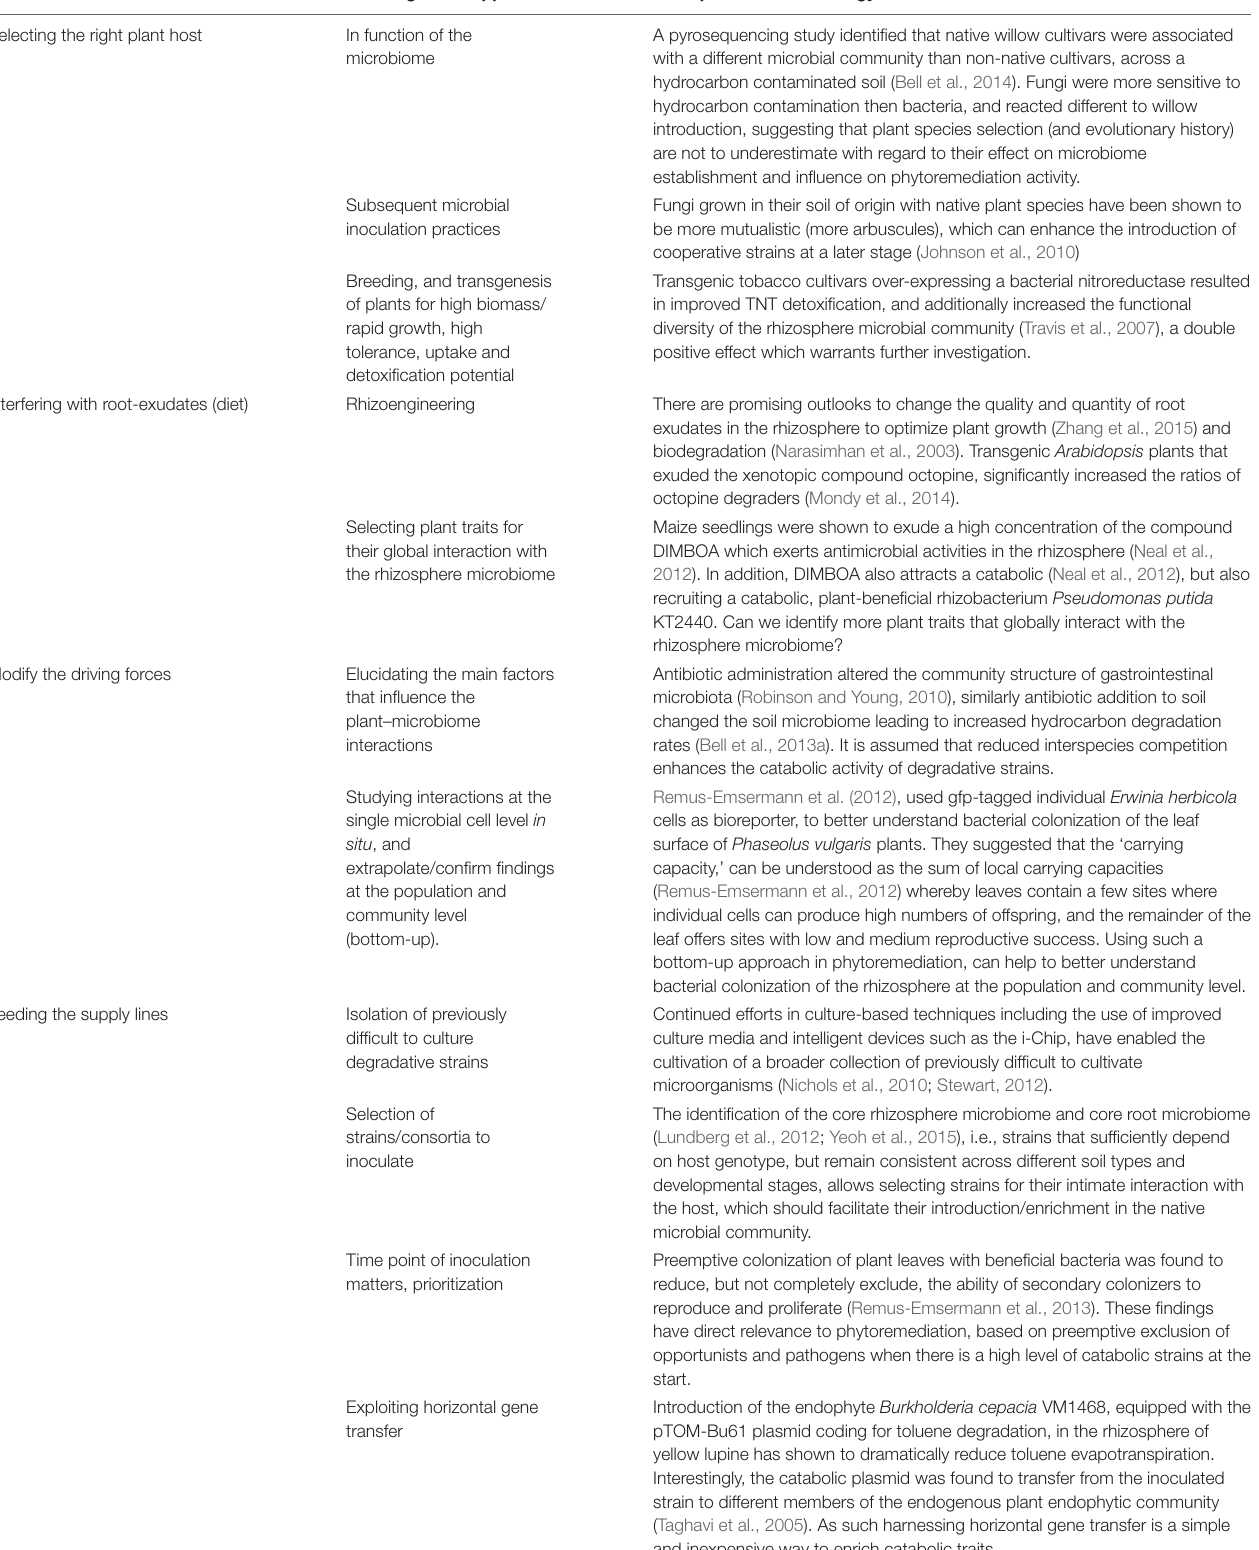
TABLE 1 | Possible ways to improve phytoremediation research using a metaorganism